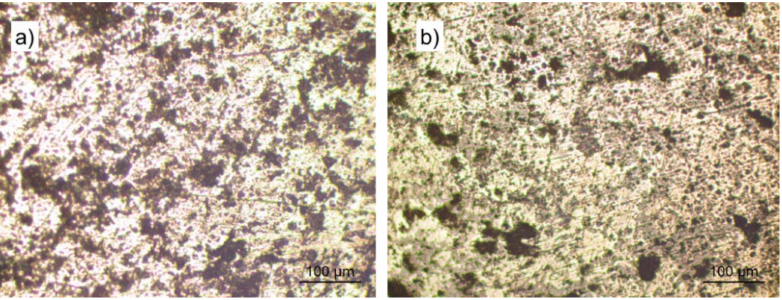
Figure 11. The coatings’ surface morphology before ( a ) and after ( b ) annealing at 800 ◦